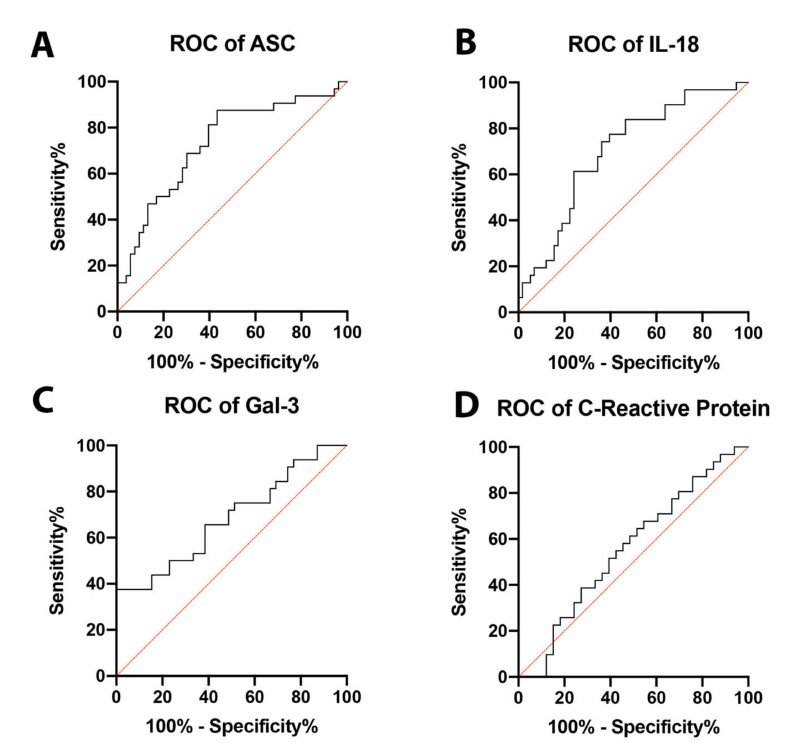
Figure 2. ROC curves for analyzed proteins. ROC curves for ASC ( A ), IL-18 ( B ), Gal-3 ( C ), and CRP ( D ) from the serum of aged-matched controls and NASH patients. N = ASC: 53 controls, 32 NASH; IL-18: 58 controls, 31 NASH; Gal-3: 39 controls, 32 NASH; and CRP: 33 controls, 31 NASH. C: Control; NASH: Non-alcoholic Steatohepatitis; ASC: Apoptosis-Associated Speck-like Protein Containing a Caspase Recruitment Domain; IL-18: Interleukin-18; Gal-3: Galectin-3. ROC: Receiver Operating Characteristics.